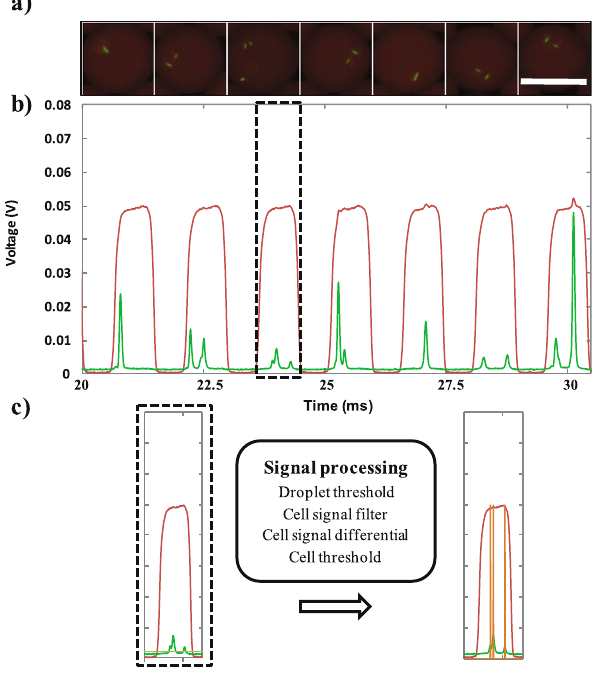
Figure 1. Schematic representation of the cell counting procedure. eGFP-transformed E. coli cells were encapsulated in droplets. ( a ) Fluorescent images of red coded droplets encapsulating E. coli cells at λ = 2 (mean cell per droplet ratio). Scale bar: 30 µ m. Corresponding time sequence of red and green fluorescence signals is shown in ( b ). Dashed black rectangle encloses a signal sample corresponding to a droplet chosen as an example to illustrate the signal processing analysis. ( c ) The signal processing method is schematized in the black box. Briefly, each droplet is identified by applying a droplet threshold on the red fluorescence channel. The